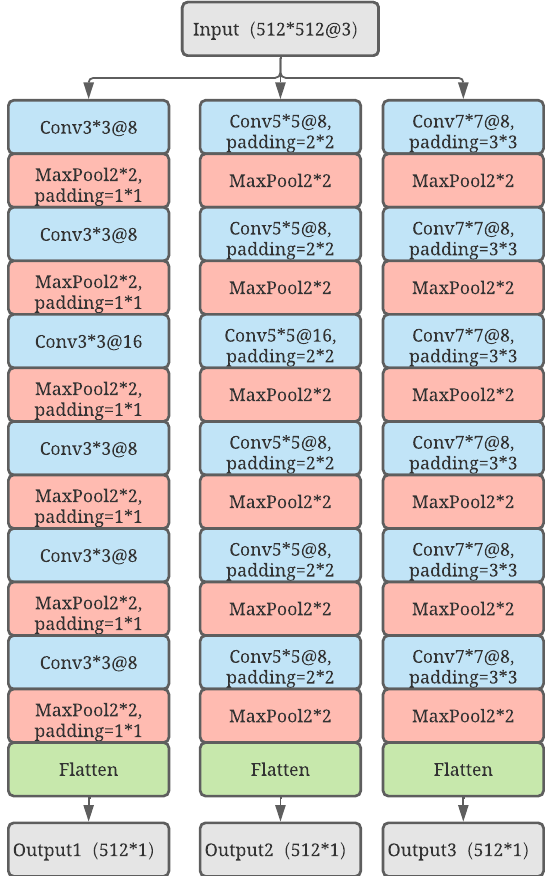
Figure 5. Details of the design of the three experts with different sizes of